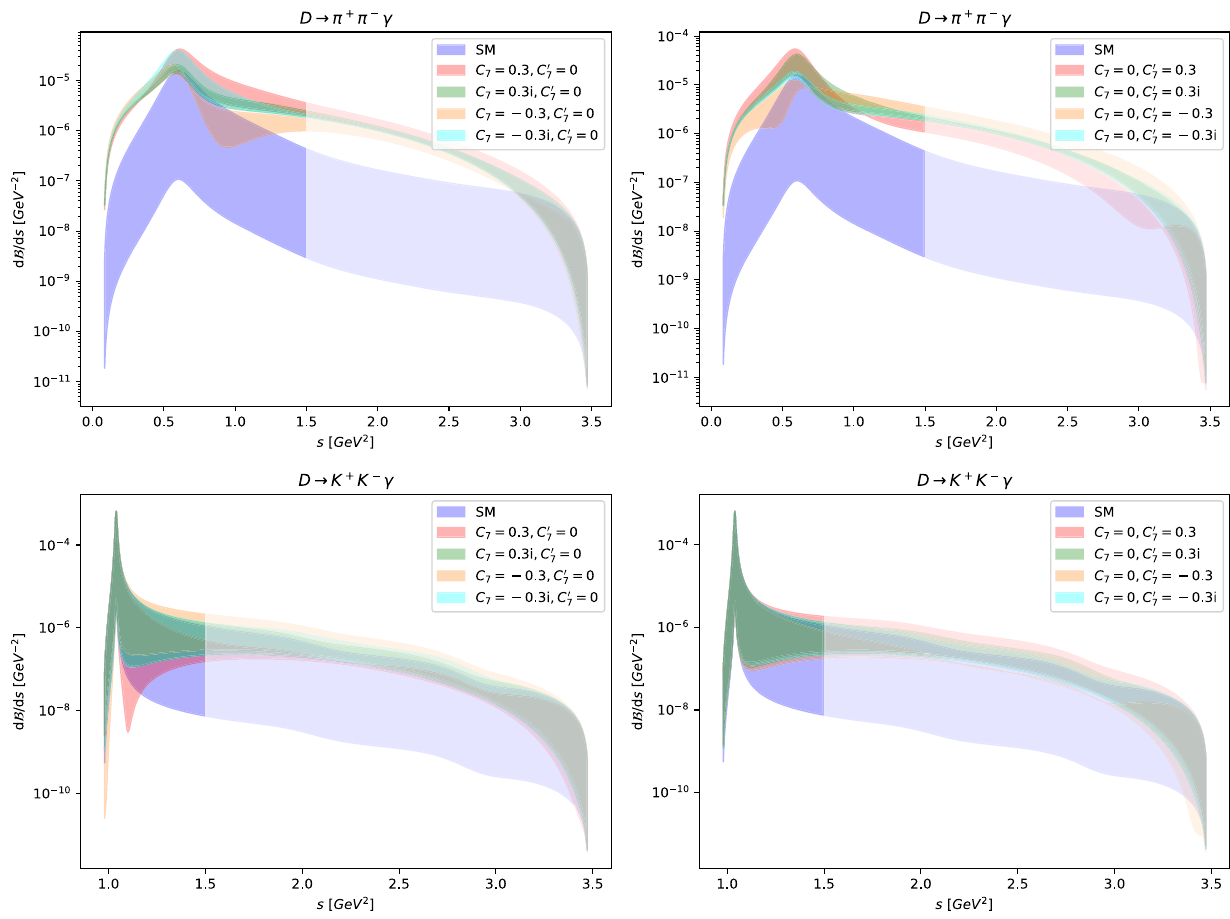
Fig. 7 Comparison of QCDF-based SM predictions of differential branching ratios for D → π + π − γ (upper plots) and D → K + K − γ (lower plots) within different BSM scenarios. One BSM coefficient is set to zero while the other one exhausts the limit (37) with CP-phase 0 , ± π/ 2